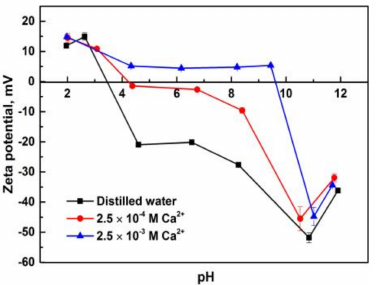
Figure 6. Zeta potential of apatite as a function of pH in the absence and presence of calcium